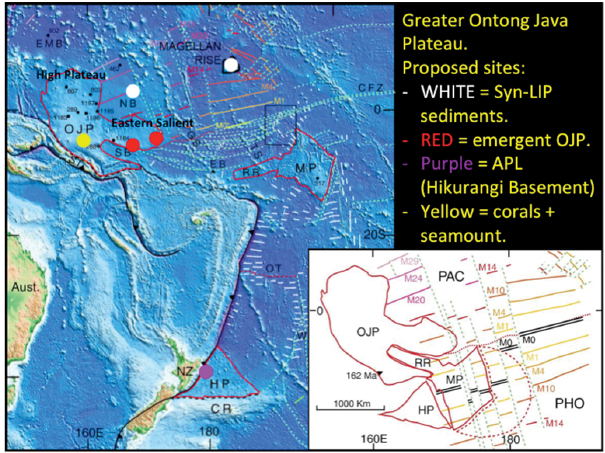
Figure 2. Present configuration of large igneous provinces (LIPs) in the SW Pacific (outlined in red) with proposed drilling sites. The in- set shows reconfiguration of the Greater Ontong Java Plateau (OJP) suggesting the Ontong Java and Hikurangi (HP) plateaus and the Manihiki Plateau (MP) all formed during a single event adapted from Taylor (2006). Note: Robbie Ridge (RR), Ellis Basin (EB), East Mariana Basin (EMB), Nauru Basin (NB), Clipperton Frac- ture Zone (CFZ), Osbourn Trough (OT) and Chatham Rise (CR) are also shown. The inset shows a reconstruction at ∼ 125Ma prior to breakup and before Pacific (PAC) – Phoenix (PHO) spreading (from Taylor,